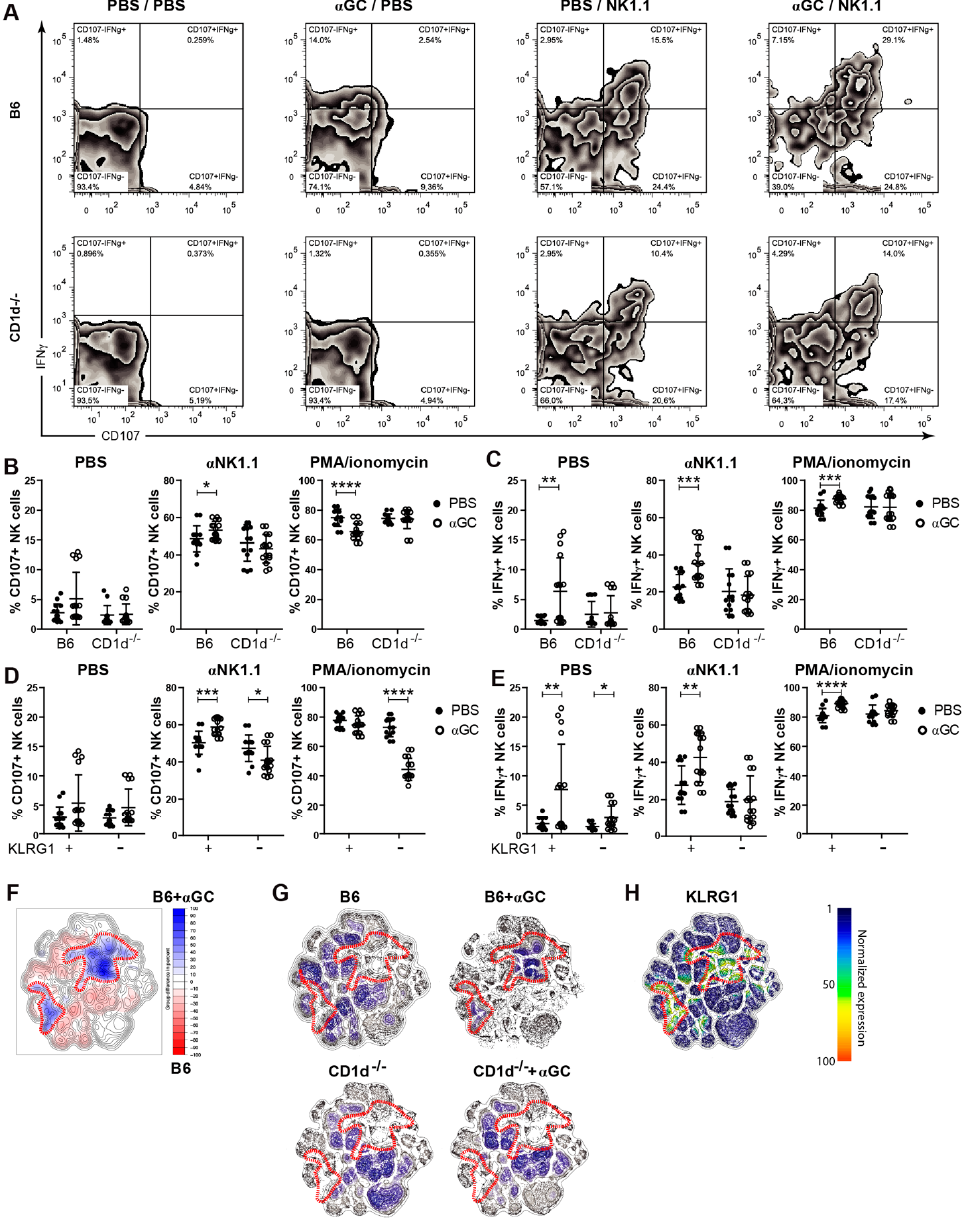
Figure 2. Activation of KLRG1+ natural killer (NK) cell subsets after in vivo stimulation with α GC . C57Bl/6 or CD1d − / − mice were injected i.v., with PBS or soluble α GC. 3 days after in vivo stimulation, degranulation (by CD107 positivity) and cytokine production capacity (IFN γ production) were assessed. ( A ) Representative plots showing IFN γ ( y -axis) vs. CD107 ( x -axis) of unstimulated (PBS/PBS), in vivo α GC-stimulated and in vitro unstimulated ( α GC/PBS), in vitro stimulated naïve (PBS/NK1.1) and in vivo plus in vitro stimulated ( α GC/NK1.1) WT NK cells. Gated on single/live/CD3 − NKp46 + cells. ( B ) CD107 and ( C ) IFN γ production of C57Bl/6 and CD1d − / − NK cells stimulated with PBS (unstimulated), α NK1.1 or phorbol myristate acetate (PMA)/ionomycin. ( D ) CD107 and ( E ) IFN γ production of KLRG1 + vs. KLRG1 − NK cells of B6 mice, stimulated with PBS (unstimulated), anti-NK1.1 or PMA/ionomycin. ( F – H ) Flow cytometry data of mice of four groups (B6, B6 + α GC, CD1d − / − , CD1d − / − + α GC) was analyzed with t -distributed stochastic neighbor embedding algorithm as previously described [55]. Combining B6 with B6 + α GC, areas with a 10% increase of cells were identified and manually gated ( F ) and subsequently applied to all remaining tSNE plots of different treatment groups individually ( G ). Data are pooled from 6 independent experiments with 14–16 mice per group ( A – E ) or from 3 independent experiments with 6 mice per group ( F–H ). Unpaired, two-tailed t -test ( B – E ) was used to determine statistical significance. Error bars indicate mean ± SD and statistical significance is indicated as * p < 0.05, ** p < 0.01. *** p < 0.001, **** p <